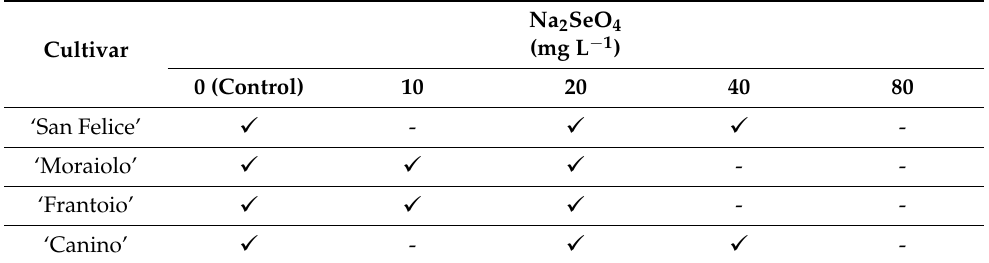
Table 6. Na 2 SeO 4 concentrations used for each cultivar in the second and third subcultures.